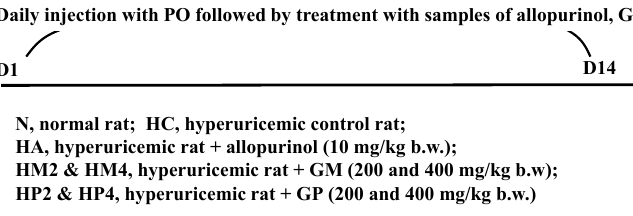
Figure 5. Protocol of hyperuricemia induction and treatment of rats. Sprague-Dawley rats were intraperitoneal injected with potassium oxonate (PO; 250 mg/kg b.w.) daily to induce hyperuricemia. The rats in the normal (N) group did not receive any treatment throughout the animal experiment. PO-injected rats were randomly divided to 6 groups ( n = 8): hyperuricemic control (HC), daily treated with allopurinol (10 mg/kg b.w.; HA), daily treated with GM (200 or 400 mg/kg b.w.; HM2 or HM4), or daily treated with GP (200 or 400 mg/kg b.w.; HP2 or HP4). Except for the rats in N and HC groups, the other rats were orally treated with allopurinol or G. lucidum formula daily. The rats were treated for 2 weeks and then sacrificed on day 15 to individually isolate and weigh the kidney and liver. The blood samples, as well as liver samples, were harvested for further analysis.